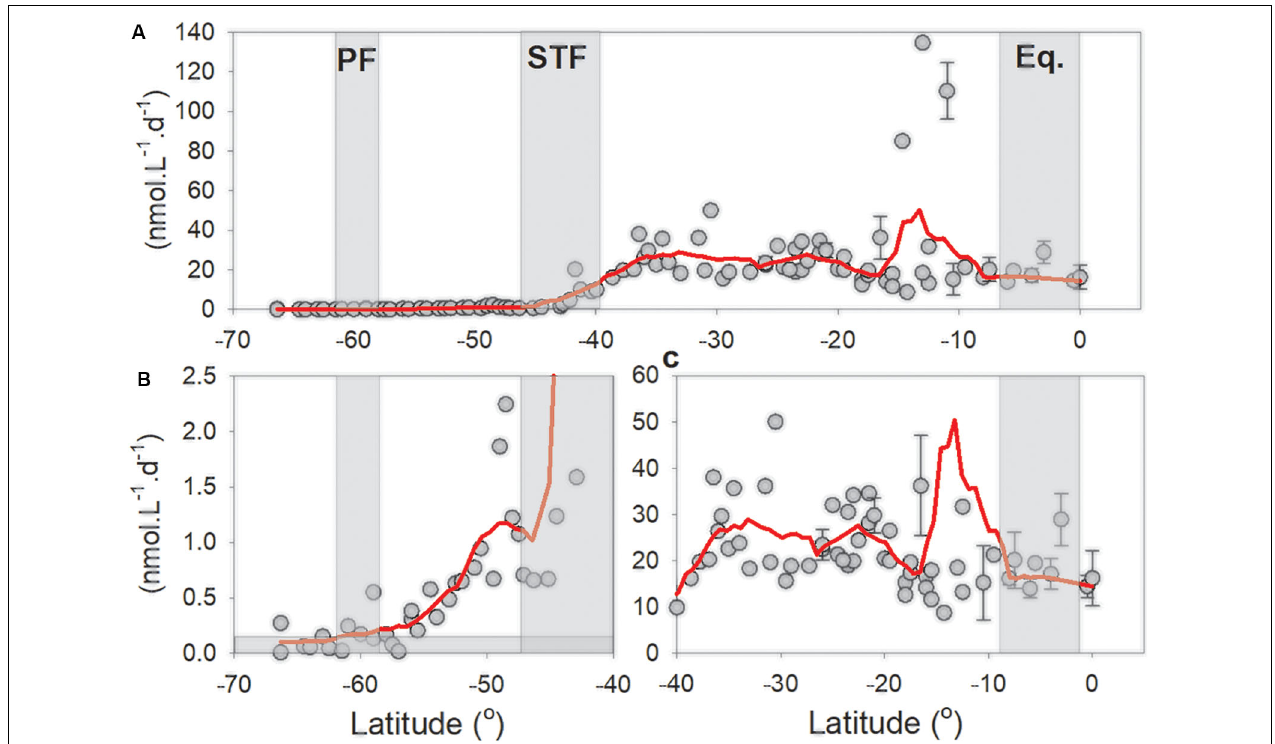
FIGURE 3 | (A) N 2 fixation rates along the P15S GO-SHIP transect from the ice edge up to the equator. Red line is a negative exponential smoothing curve with a first polynomial order. (B) Higher resolution plot of N 2 fixation rates between 66 ◦ and 40 ◦ ; note Y -axis is now from zero to 2.5 nmol L − 1 d − 1 . Horizontal filled gray bar denotes the average minimum quantifiable N 2 fixation rates (calculated according to Montoya et al. (1996); Supplementary Table 1 provides the MQR at a one-degree resolution). (C) High resolution plot of N 2 fixation rates between 40 ◦ and 0 ◦ ; note Y -axis is now from zero to 60 nmol L − 1 d − 1 . Gray rectangles denote oceanographic fronts (PF, Polar front; STF, Subtropical Front; Eq, Equatorial upwelling zone). Standard deviations are presented at the stations were we had duplicate and or triplicate